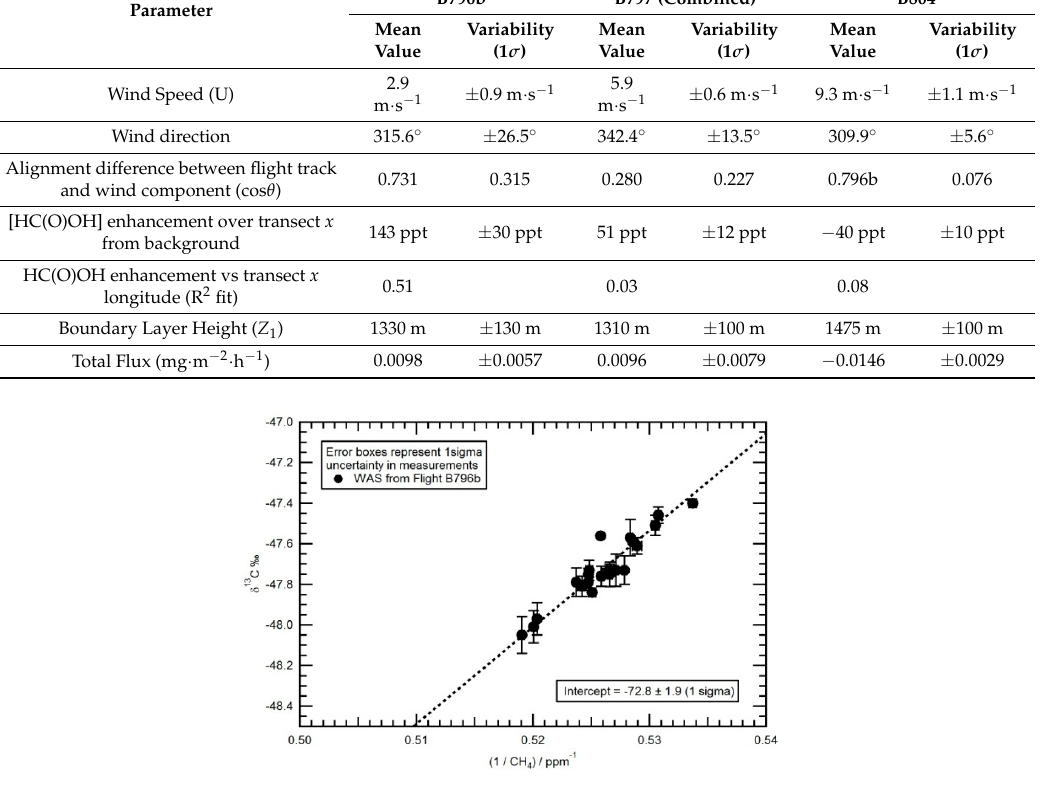
Table 1. The mean average values for the term variables used in the flux calculation, as well as one times the standard deviation (1 σ ) of the mean value used to calculate the overall flux uncertainty.